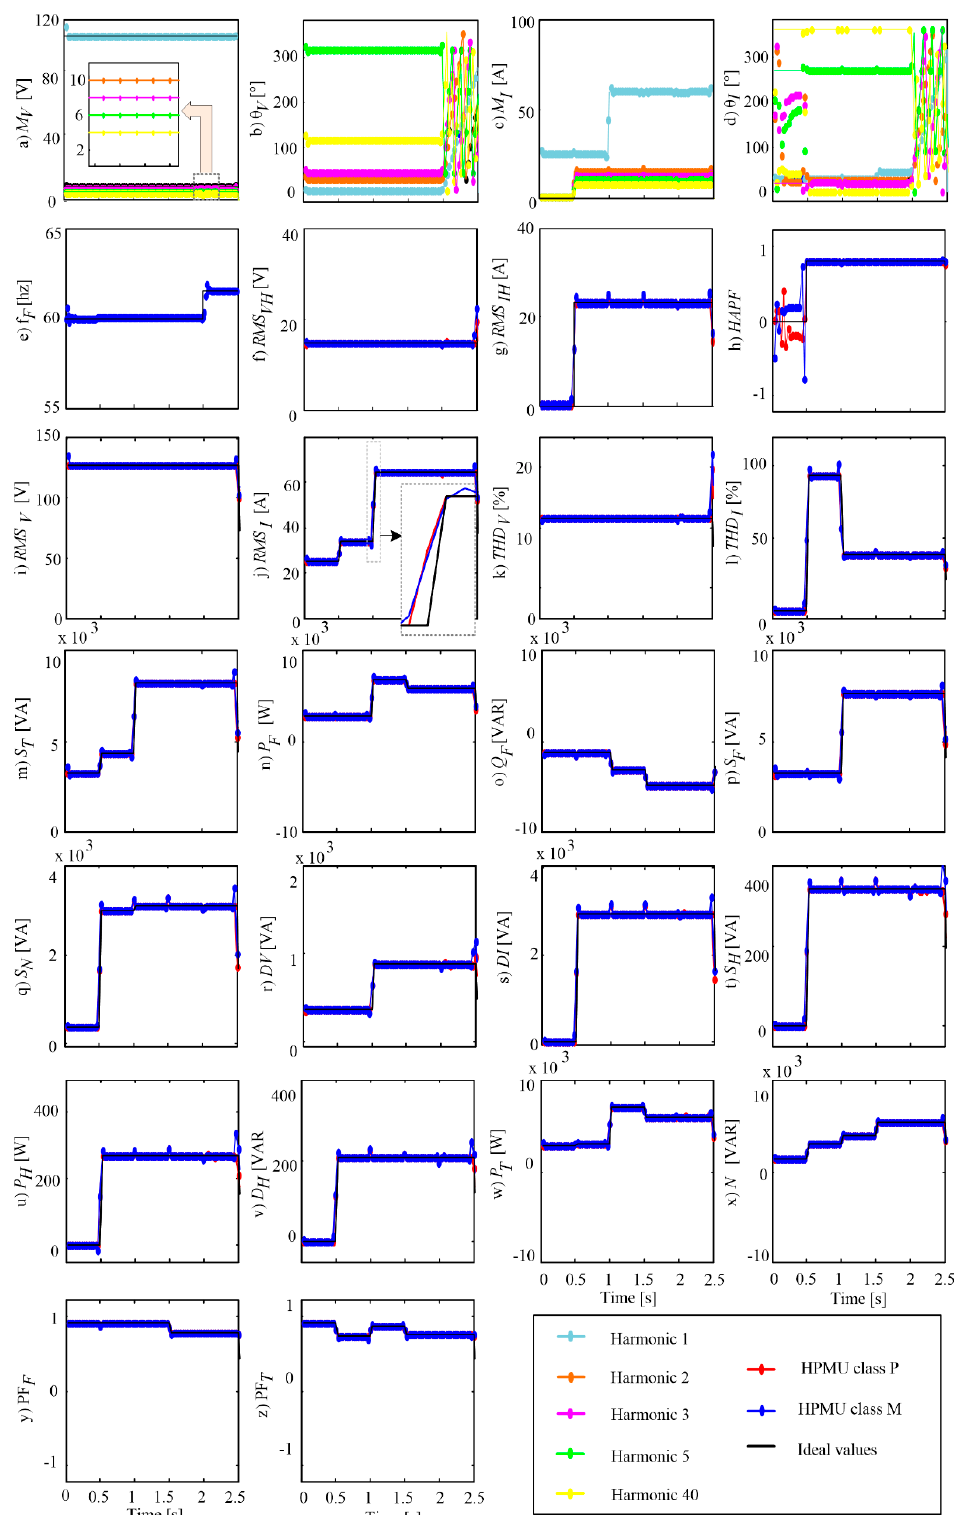
Figure 5. Results for harmonic phasors of voltage and current, global harmonic parameters, and